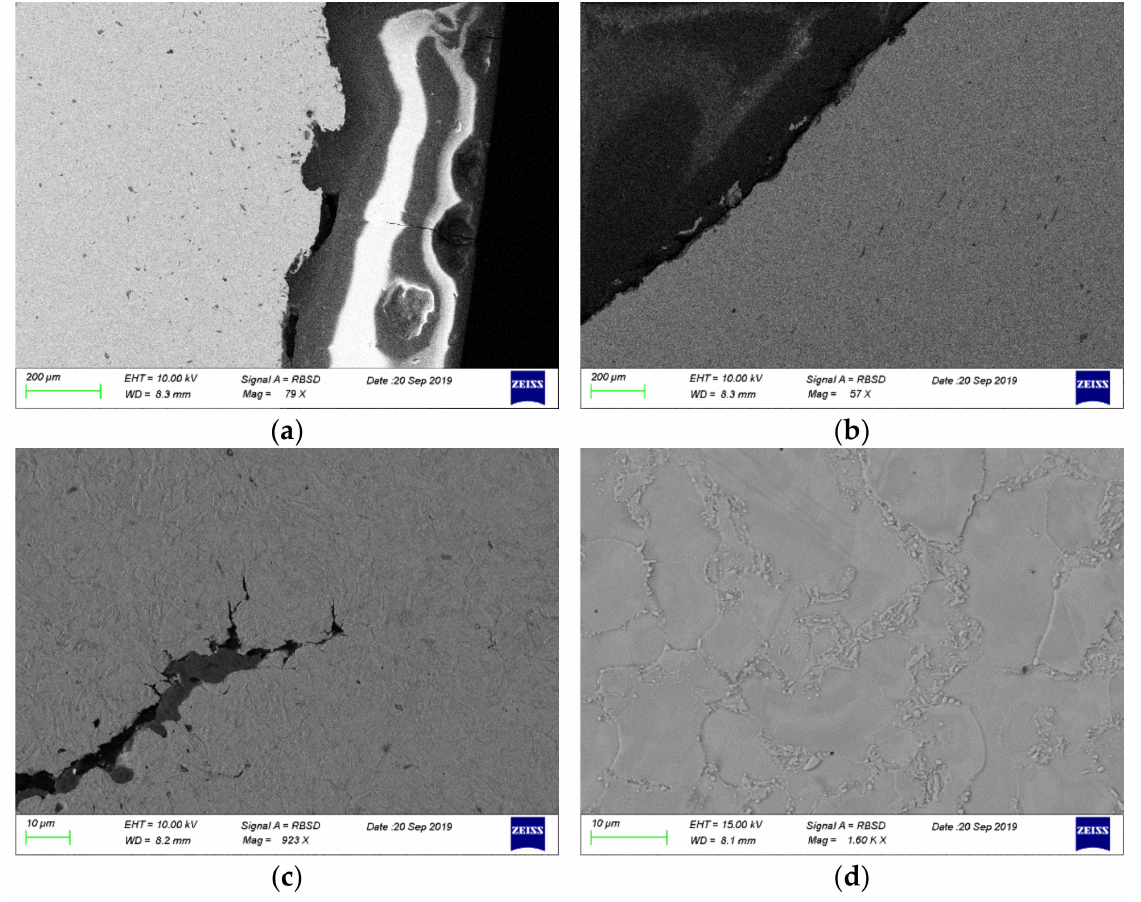
Figure 9. SEM analysis of 300-h corroded specimens ( a , c ) Tempcore B and ( b , d ) Dual Phase F.